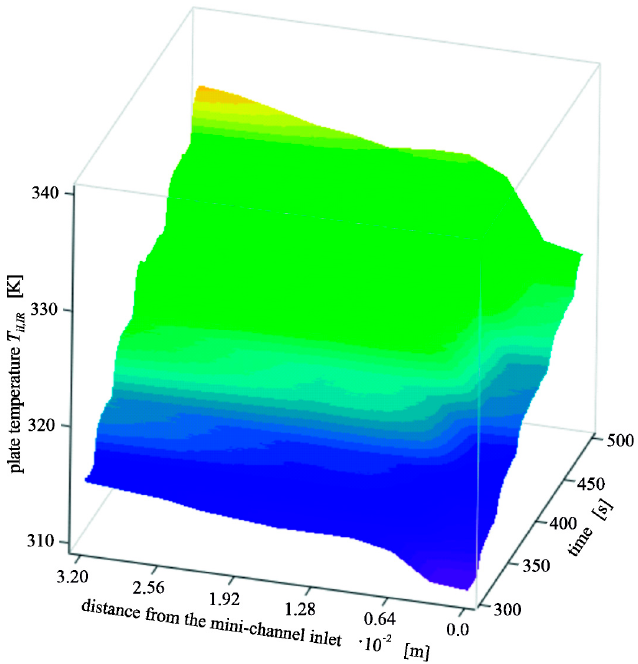
Figure 3. Temperature of the heated plate from infrared measurement versus time and distance from the mini-channel inlet; experimental parameters are listed in Table 1. Images of two-phase patterns were recorded at a speed of 1 fps with resolution of 360 × 360 pixels. For further processing, only a part of the images corresponding to the central mini-channel were taken. It was necessary to load images to our specialist soft- ware environment based on LabVIEW functions. Each digital photo was loaded and an- alyzed as a binarized image. A set of pixels contained in ten areas evenly divided along each image was taken sequentially. To determine void fraction during the next stage of the program, the number of pixels corresponding to the gas phase were counted and di- vided by the total number of pixels. For the areas partially filled with vapor, the proce- dure of closing bubbles was used. It is worth mentioning that two-phase pattern images correspond to the images recorded by an infrared camera, which are taken for further processing and computation. A scheme showing the distribution of areas corresponding to two-phase flow patterns, assumed for void fraction calculation is illustrated in Figure 4. In Figure 5, void fraction obtained from the calculations according to the authors’ own program, versus time and the distance from the mini-channel inlet is presented.